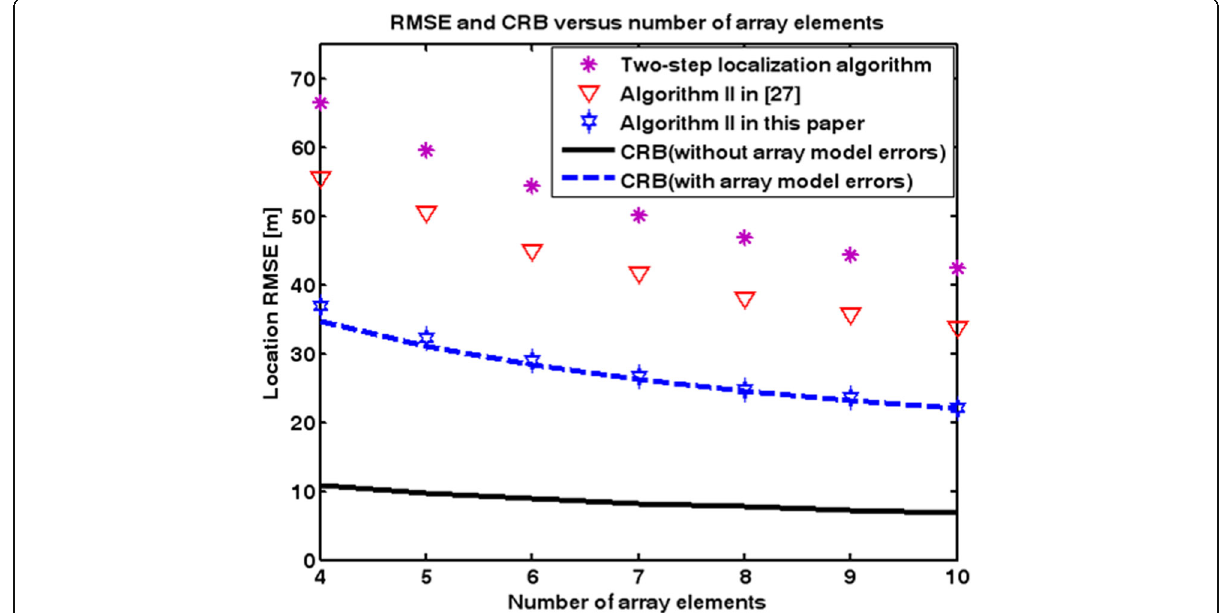
Fig. 10 RMSEs of localization methods and the corresponding CRBs as a function of number of array elements for case of known signal waveform